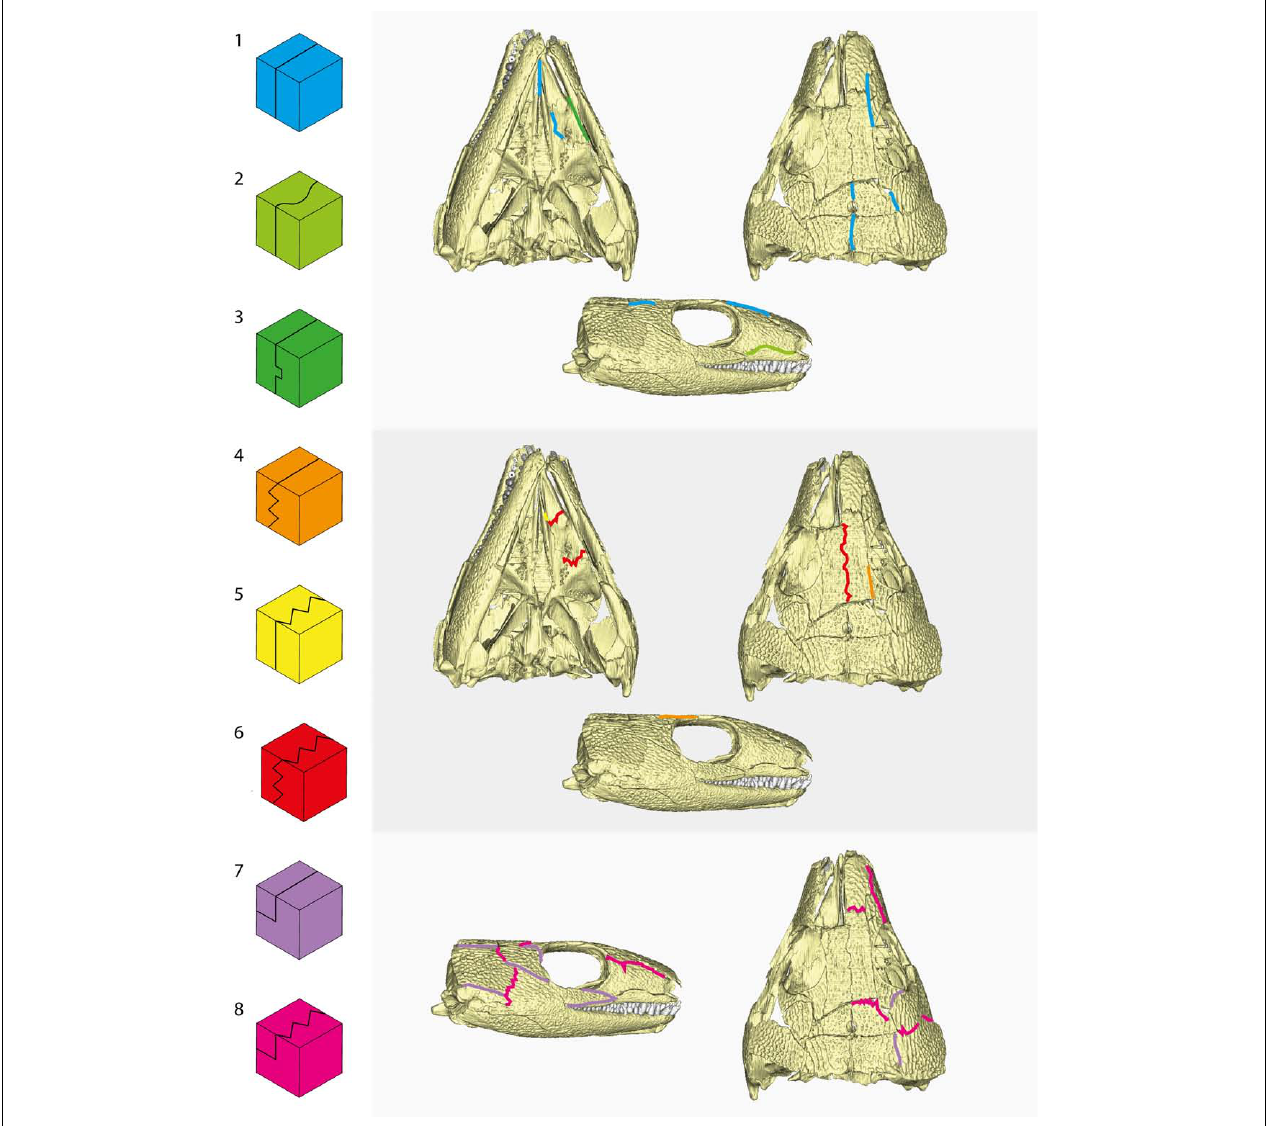
FIGURE 10 | Suture types observed in the dermatocranium of OMNH 44816 and their position in the skull. 1, butt joint; 2, tongue-and-groove joint; 3, slot joint; 4, Type-A interdigitation; 5, Type-B interdigitation; 6, Type-C interdigitation; 7, stepped joint; 8, stepped interdigitation. Terminology mostly after Jones et al.